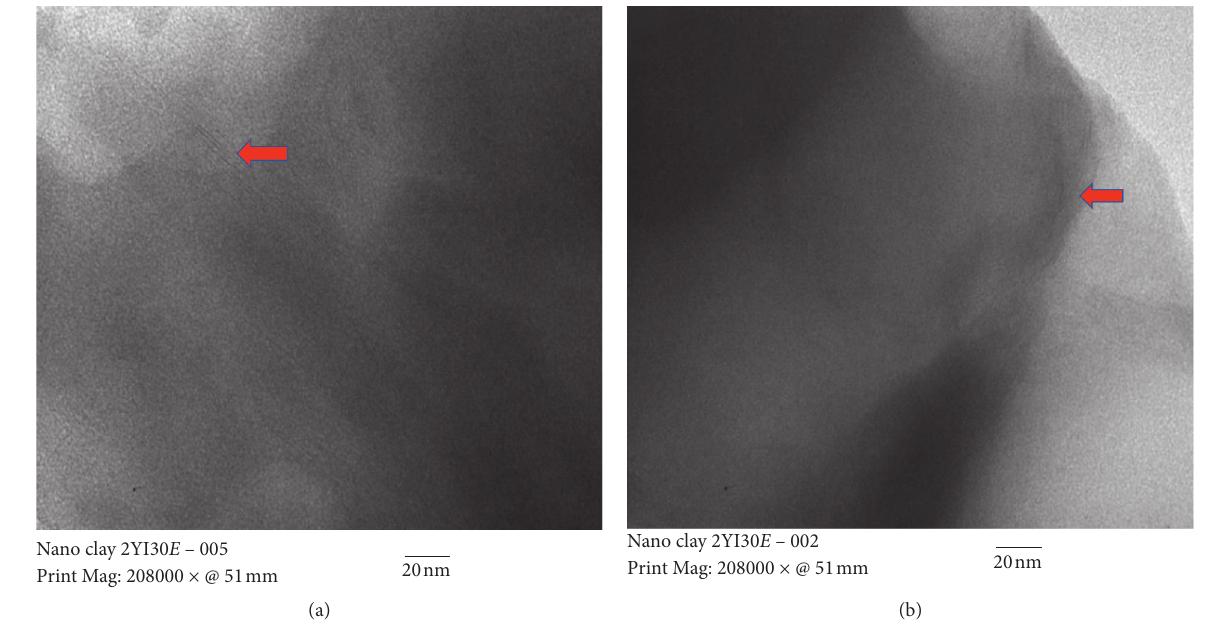
Figure 1: TEM image of epoxy Epikote 240/nanoclay I.30E nanocomposite material: (a) 2% wt nanoclay I.30E, (b) 3% wt nanoclay I.30E.